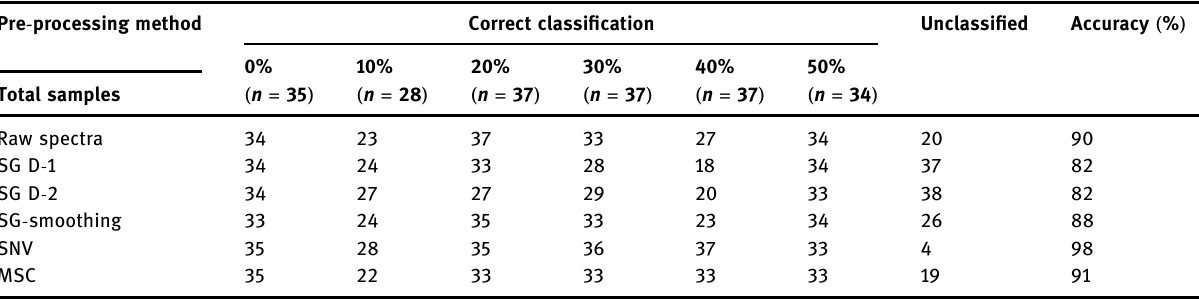
Table 6: PLS - DA model performance for classi fi cation of maltodextrin - added in butter fl y - pea extract powder based on various pre - pro - cessed spectra